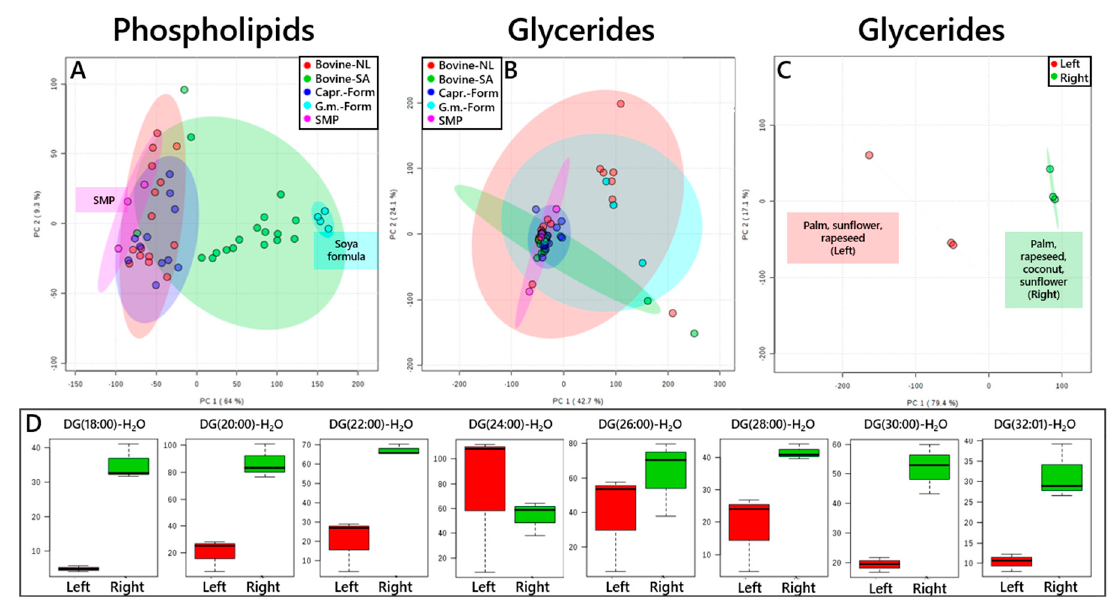
Figure 3. PCAs of bovine-based infant formula sold in South Africa and the Netherlands, caprine- and soya-based infant formulae sold in the UK and skimmed milk powder sold in the UK. Panel ( A ), phospholipids. Panel ( B ), triglycerides and diglycerides. Panel ( C ), Triglycerides and diglycerides for Dutch brand 2 (NLB2), with the three most abundant fatty ingredients marked in two subgroups. Panel ( D ), important loading variables for NLB2 that are consistent with independent profiling of coconut triglycerides. R 2 values for each component are shown in parentheses on each axis. Capr., caprine; Form, formula; G. m., Glycine max ; NL, Netherlands; SA, South Africa; SMP, skimmed milk powder.